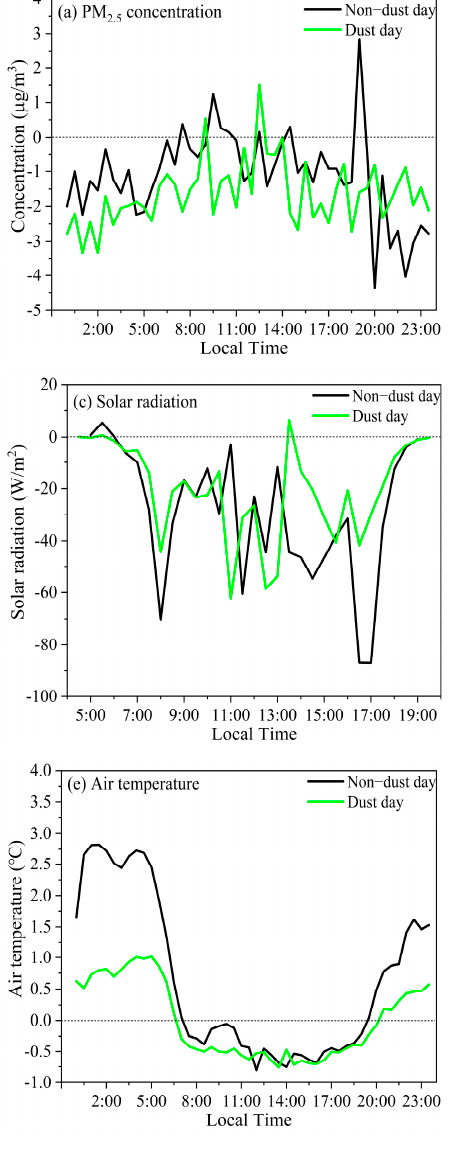
Figure 6. Mean diurnal variations in the di ff erence between PM 2.5 concentration ( a ), PM 10 concentra- tion ( b ), SR ( c ), WS ( d ), T ( e ), and RH ( f ) at the top and bo tt om of the dunes for the non-dust and dust weather during observation in the TD. The solar radiation at the top of the dunes was lower than that at the bo tt om. The maximum solar radiation at the top of dunes was 749 W·m − 2 and 812 W·m − 2 at the bo tt om, with a di ff erence of 63 W·m − 2 (Figure 7a). The higher solar radiation makes the tempera- ture at the bo tt om of the dunes 0.5°C higher than that at the top during the day; however, the opposite is true at night (Figure 7b). This di ff ers from previous knowledge regarding valleys. The wind speed at the top of the dune is consistently higher than that at the bot- tom, which can increase turbulence and air mixing, hence lowering air temperature dur- ing the day. Air temperature at the bo tt om is 0.7°C lower than that at the top at night (Figure 7b), indicating that there is an obvious inversion phenomenon at night. The diurnal variation